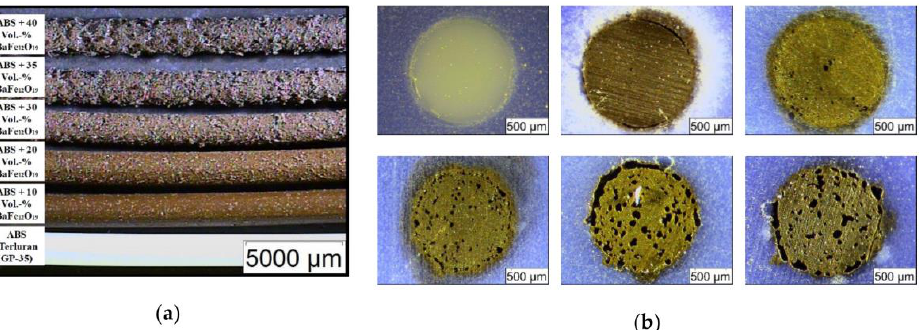
Figure 3. Microscopic images of ( a ) extruded filaments with different solid loadings; ( b ) polished cross-sections with increasing filler content. Upper row: Pure acryl butadiene styrene (ABS), 10 vol.% and 20 vol.% ferrite; lower row: 30 vol.%, 35 vol.%, and 40 vol.% ferrite. From [43], originally published under a CC-BY license.